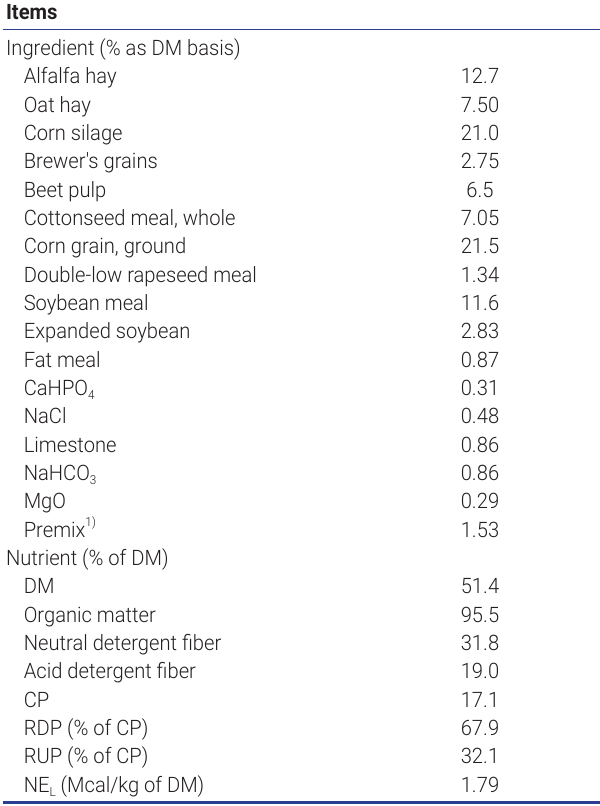
Table 1. Ingredients and nutrient composition of total mixed ration fed to the cows throughout the experiment